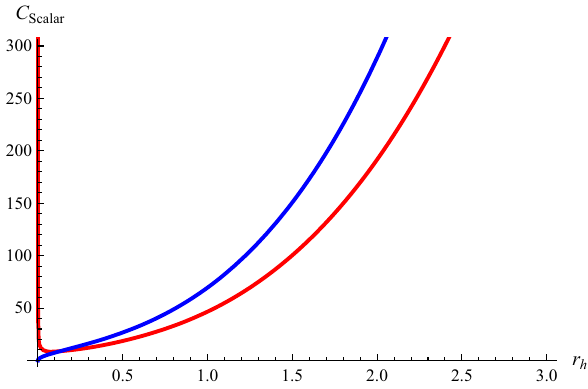
Fig. 3 C Vector - r h curve. The blue and red lines are correspond to the standard and the modified heat capacities of the spinning dilaton black hole, respectively. We set Λ = 1 ,α = 10 − 2 , j = 3 , ¯ h = J = m =